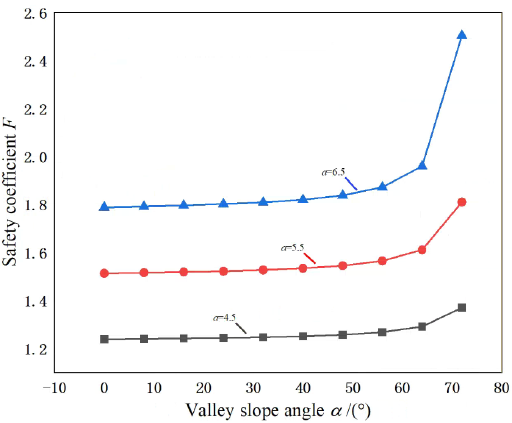
Figure 9. Variation curve of pillar safety coefficient F with valley slope angle α